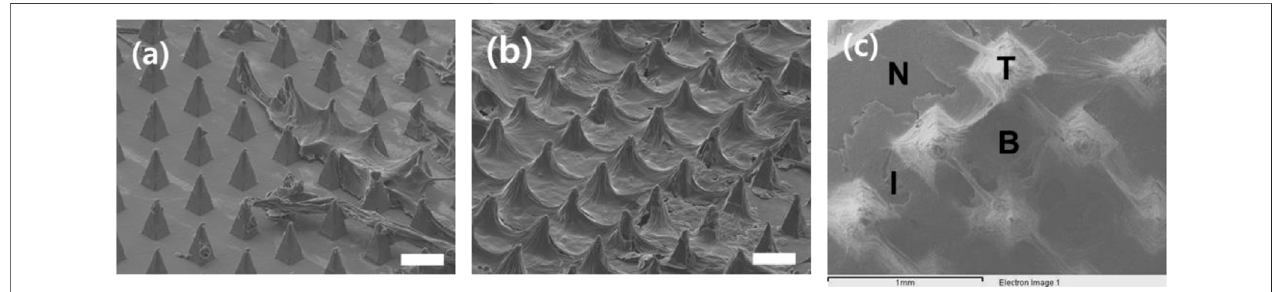
FIGURE 7 | SEM image of the surface of S-N3-I3-S7 microneedle swabs on the ex vivo pig oral mucosa after swabbing (A) 5 times and (B) 15 times (scale bars, 300 μ m). (C) Detection position by EDS. T is the tip part of the needle, I is the interval part between needles, B is the base part of the array with the sample, and N is the part without the